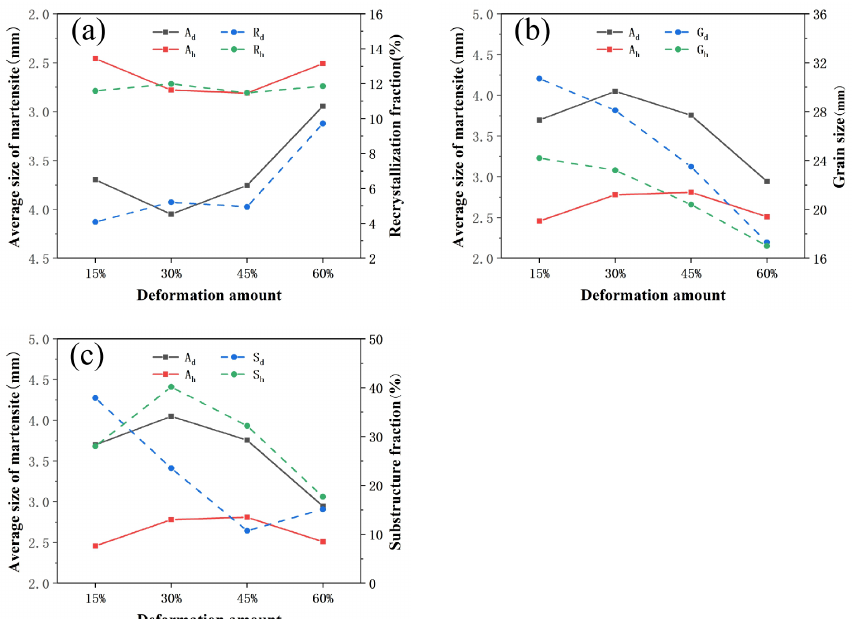
Figure 12. The average size of martensite lath dependencies of recrystallization fraction and grain size after forging and heat treatment: ( a ) Relationship with recrystallization fraction; ( b ) Relationship with grain size; ( c ) Relationship with substructure fraction.